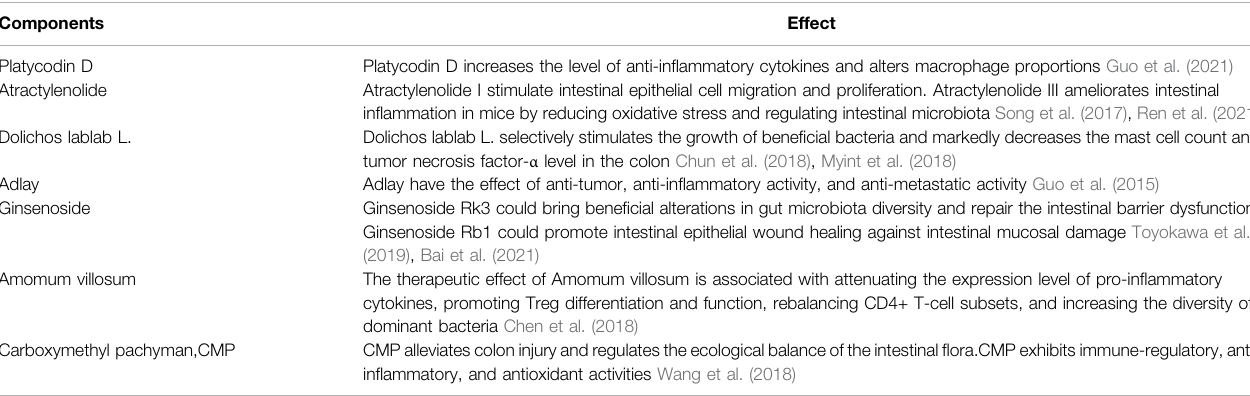
TABLE 2 | Pharmacological activities of SBP. Components Platycodin